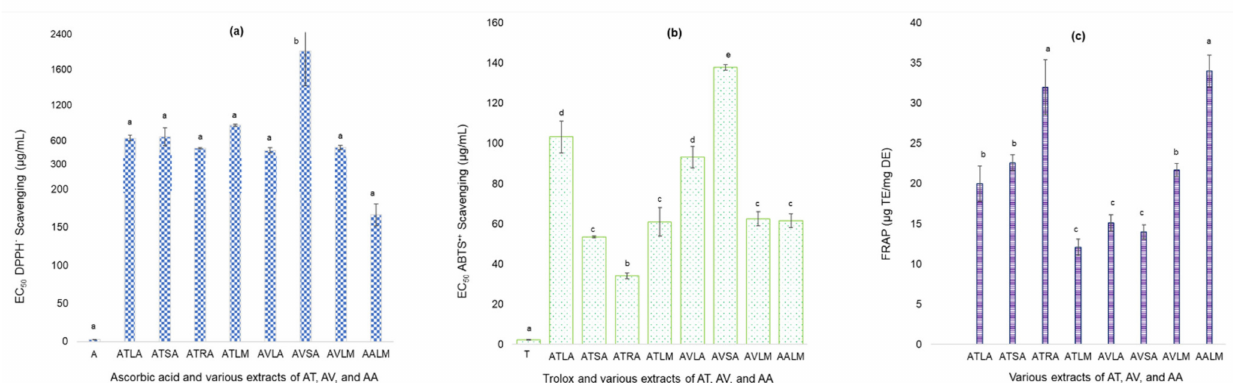
Figure 2. Antioxidant potential of extracts of Achyranthes aspera L. (AA), Amaranthus viridis L. (AV), and Amaranthus tricolor L. (AT). ( a ) Extracts vs. EC 50 ( µ g/mL) in DPPH assays; ( b ) Extracts vs. EC 50 ( µ g/mL) in ABTS assays; ( c ) FRAP values of extracts where, A = ascorbic acid; ATLA = acetone AT leaves; ATSA = acetone AT stems; ATRA = acetone AT roots; ATLM = methanolic AT leaves; AVLA = acetone AV leaves; AVSA = acetone AV stems; AVLM = methanolic AV leaves; AALM = methanolic AA leaves; T = trolox. Values are significant at p ≤ 0.01 and ≤ 0.05 (Different alphabets on the bars, show statistical difference within the same